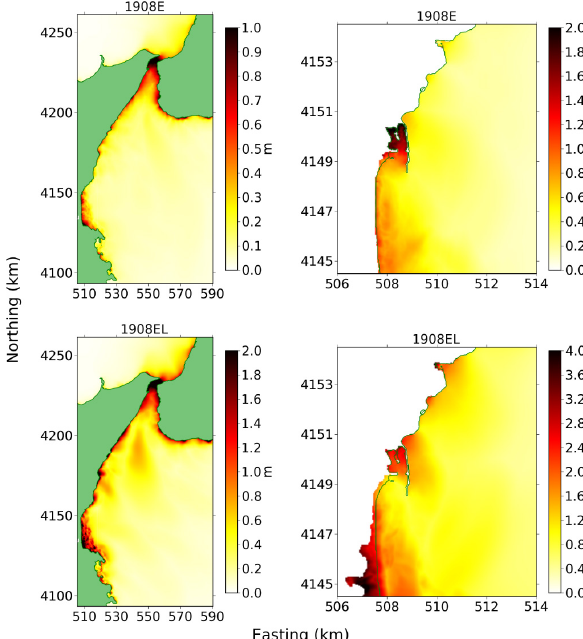
Fig. 11. Maximum water elevation for 1908 E and 1908 EL scenar- ios (left column) and their corresponding detailed maximum inun- dation in Catania (right